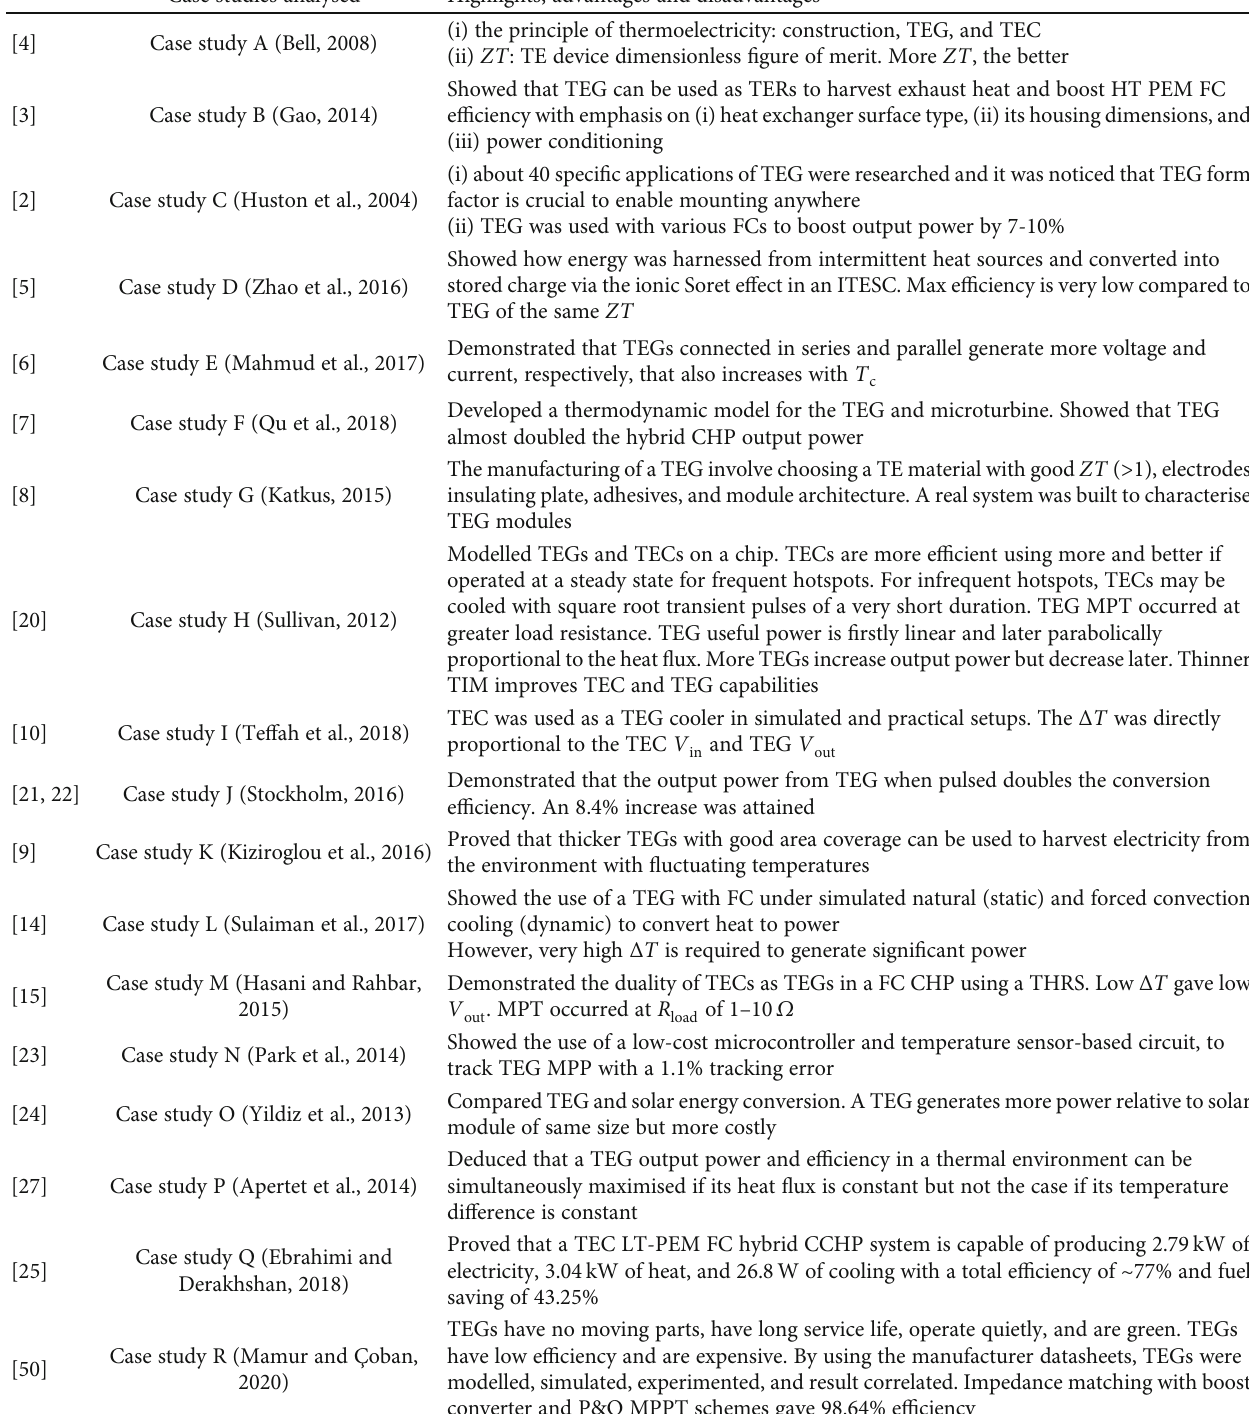
Table 3: Summary of the eighteen thermoelectricity case studies reviewed. Case studies analysed Highlights, advantages and